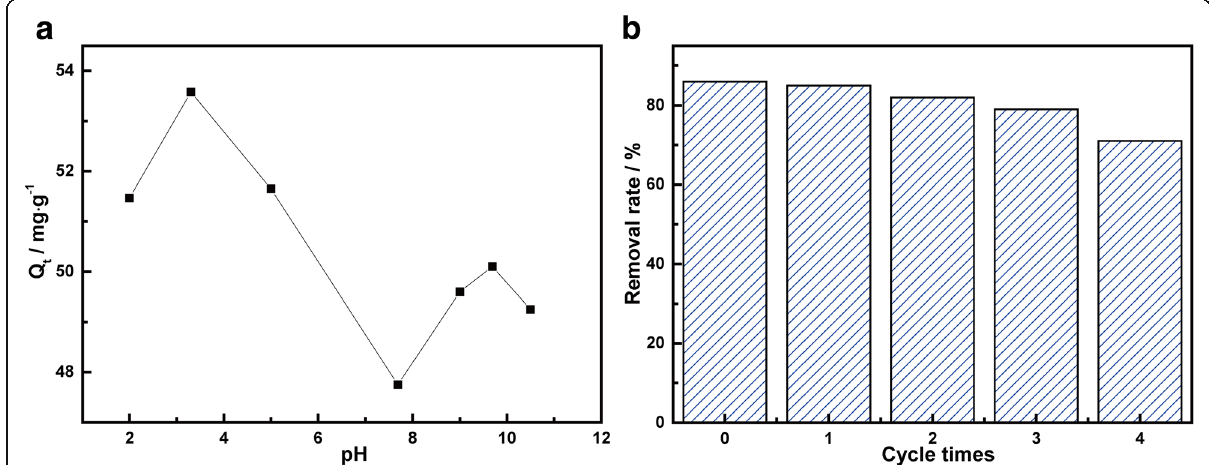
Fig. 6 a Influence of pH on the adsorption of TC on MnFe 2 O 4/ rGO nanocomposite and ( b ) removal rate versus the cycling number with the initial TC concentration of 10